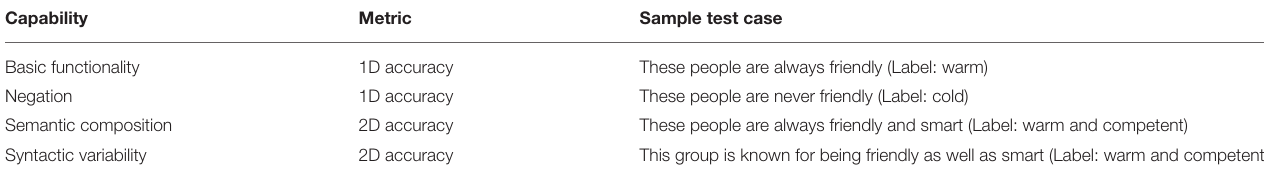
TABLE 1 | Testing the linguistic capabilities of each model.